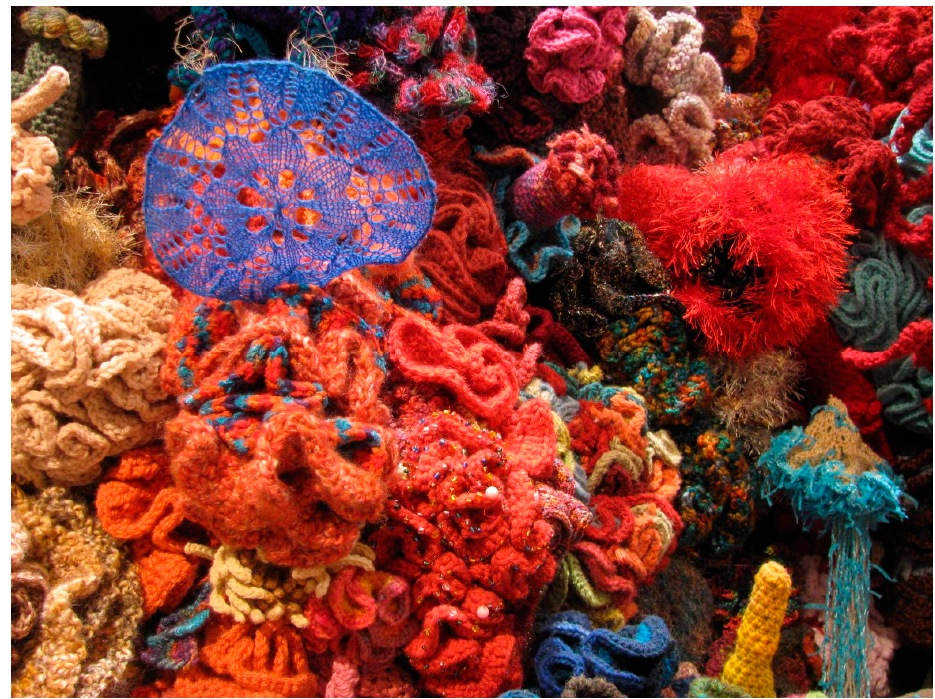
Figure 3. Detail of Hyperbolic Crochet Coral Reef exhibit at the Smithsonian’s National Museum of Natural History in Washington, D.C., 2010 (Photo by otandka https: // www.flickr.com / photos / 27498524@N00 / 5875436560 / ).